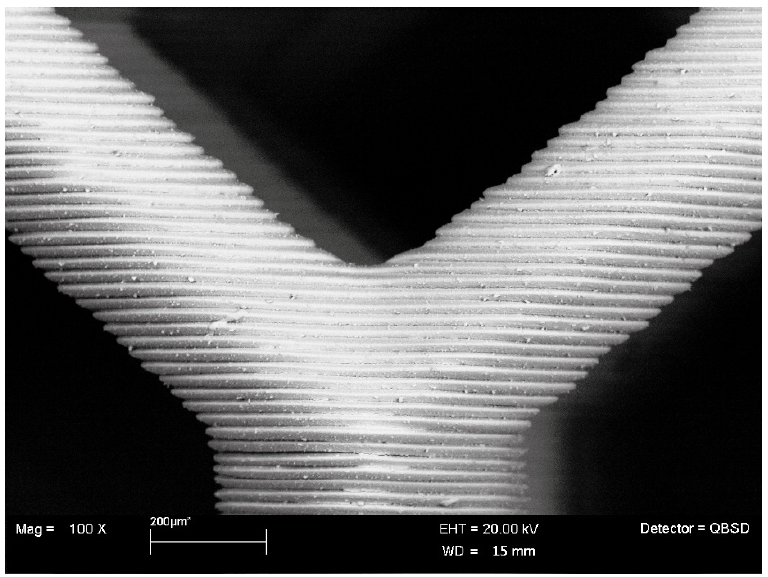
Figure 8. Micrograph of the lattice structure profile.